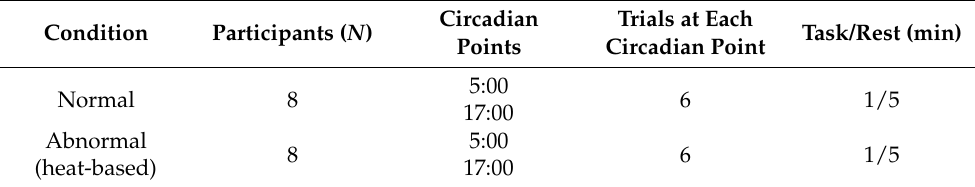
Table 4. Data collection for Experiment 2: two conditions, eight participants, two circadian points, and six trials at each circadian